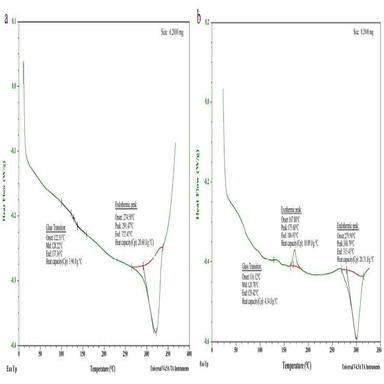
DSC thermogram (a) non-welded region (b) fusion region.